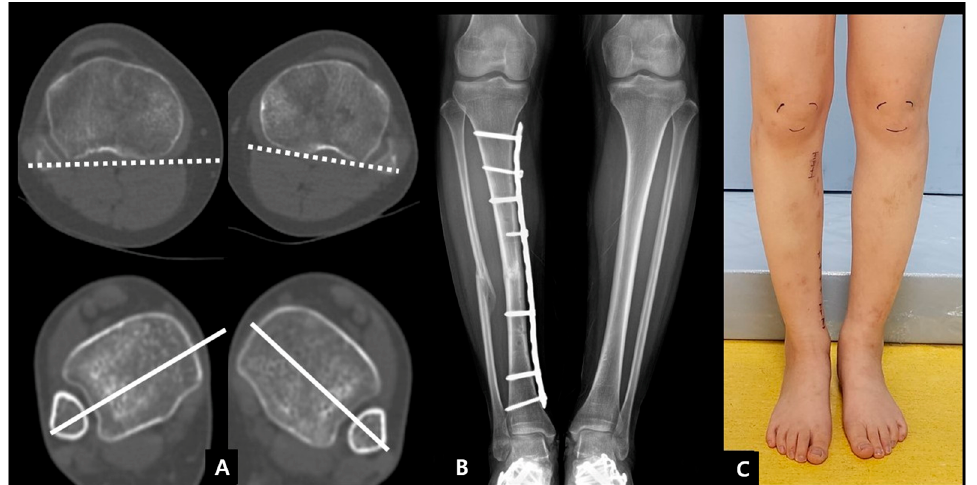
Figure 9. ( A ) Postoperative CT scan showing similar angles of rotation; ( B , C ) complete healing with the similar alignment of lower leg was observed 1 year postoperatively.